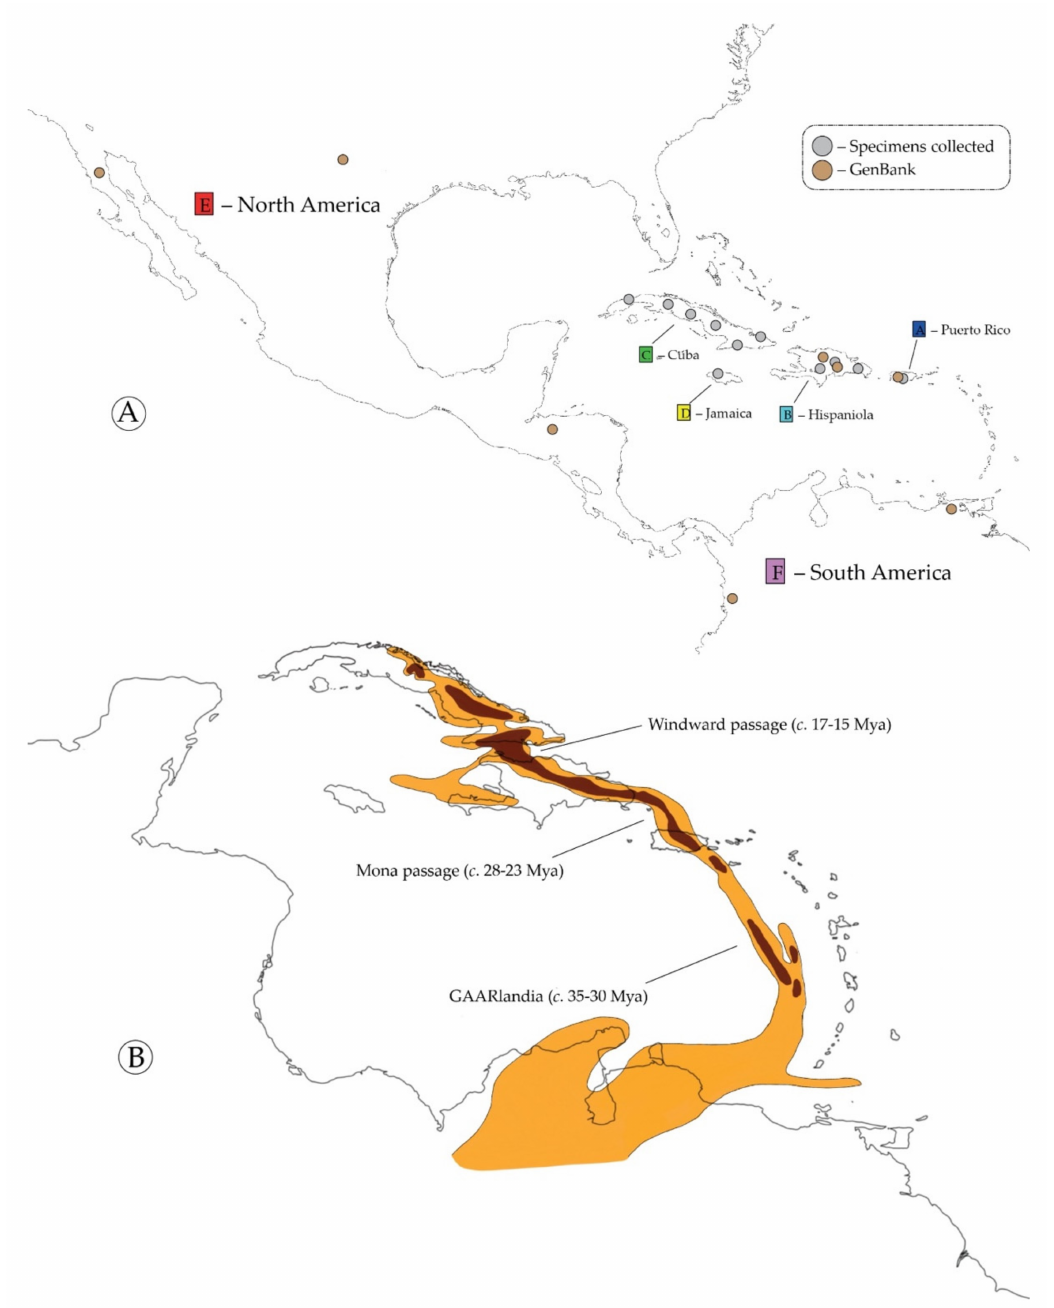
Figure 1. ( A ) Map of specimens collected for this work, including samples obtained from Gen- bank (Zhang and Maddison [69]). Area code used in the distribution ranges (A—Puerto Rico, B—Hispaniola, C—Cuba, D—Jamaica, E—North America, F—South America). ( B ) Schematic repre- sentations of the GAARlandia and Caribbean land areas available at certain time periods (Iturralde- Vinent [17], Iturralde-Vinent and MacPhee [32], MacPhee and Iturralde-Vinent [33]). Maps show simplified island positions in the respective time window used for the time-stratified